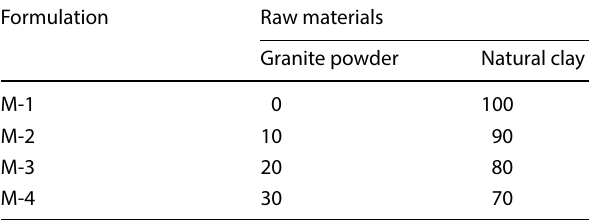
Table 2 Chemical composition of clay and GW (wt%)